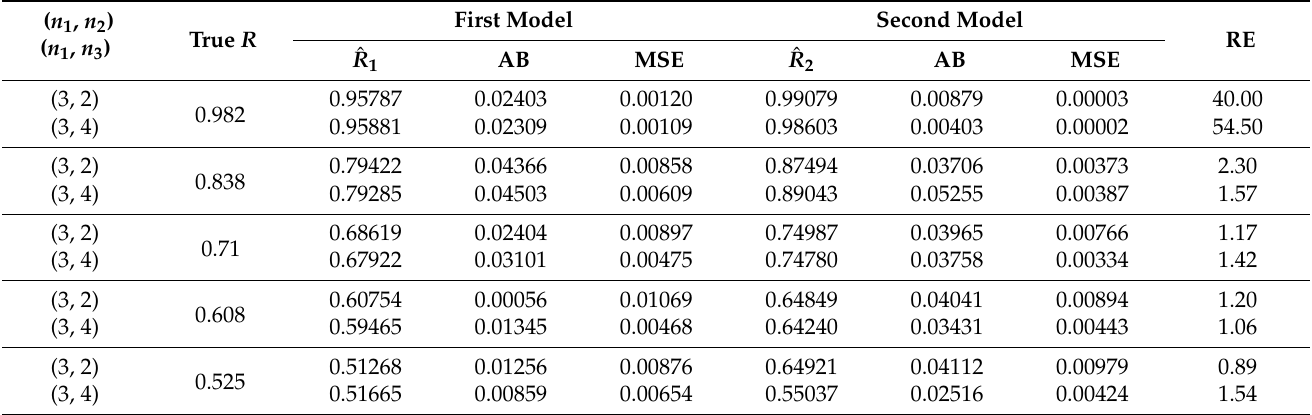
Table 6. ML estimates, AB, MSE, and RE of R 1 = P [ Y OSS < X ESS ] , R 2 = P [ Z OSS < X ESS ]